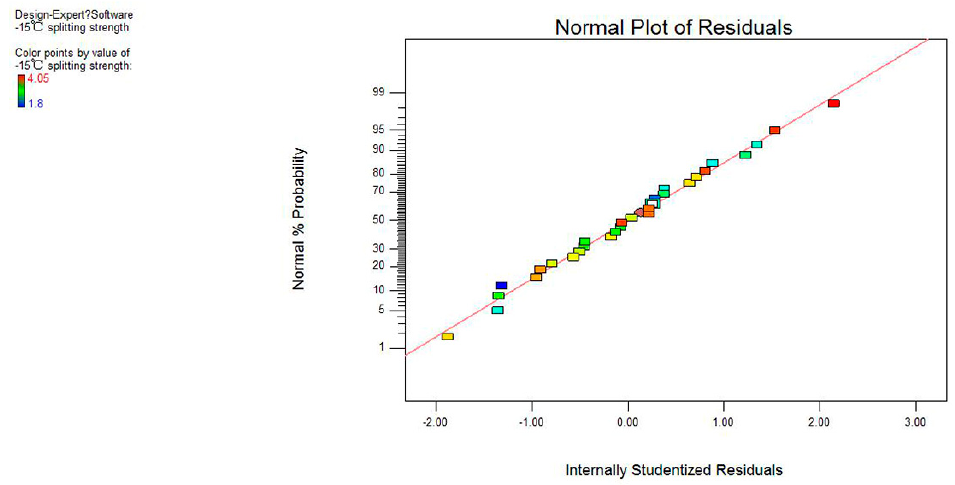
Figure 3. Normal probability plot of residuals of − 15 °C splitting strength.